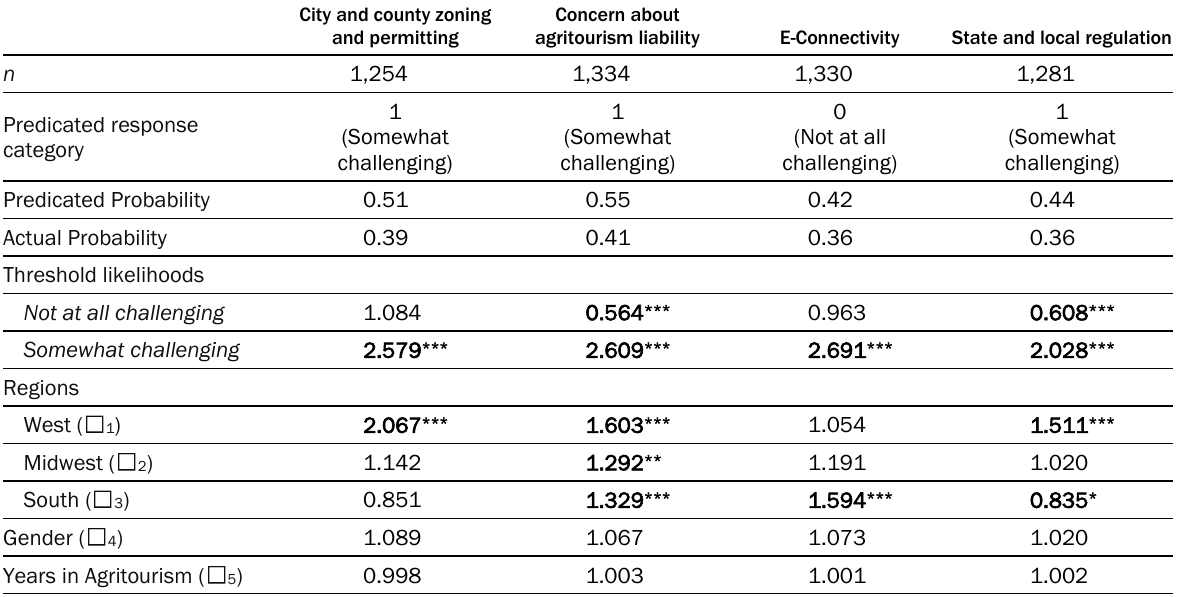
Table 1. Ordinal Regression Output of Challenges by Region Where Northeast Is Omitted City and county zoning and